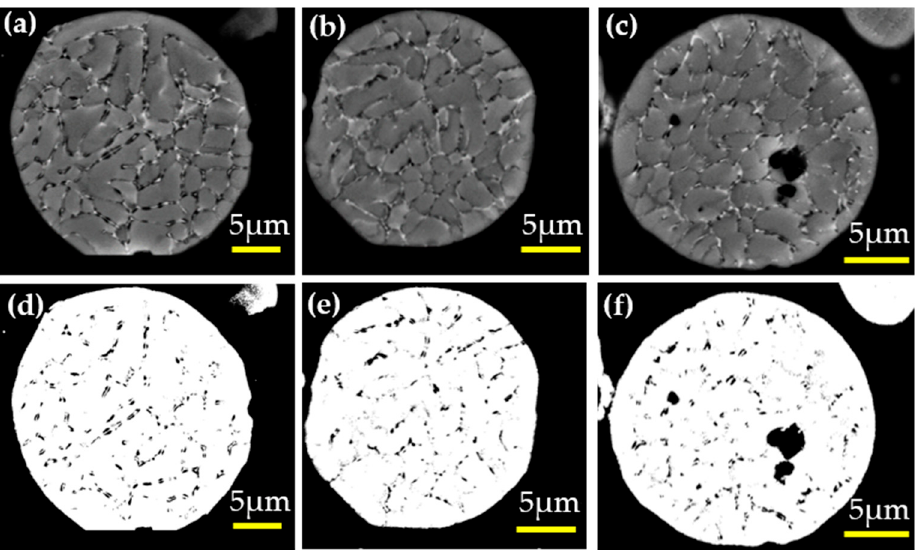
Figure 16. ( a – c ) Gas-atomized 20 µ m Al-2.63Cu-1.56Li-0.28Mg powder in backscattered electron primary FCC phase (gray) and interdendritic phases (black); ( d – f ) Eutectic areas of Al-2.63Cu-1.56Li-0.28Mg powder by a threshold algorithm using ImageJ. Table 5. Eutectic fraction measurement of gas-atomized 20 µ m Al-2.63Cu-1.56Li-0.28Mg